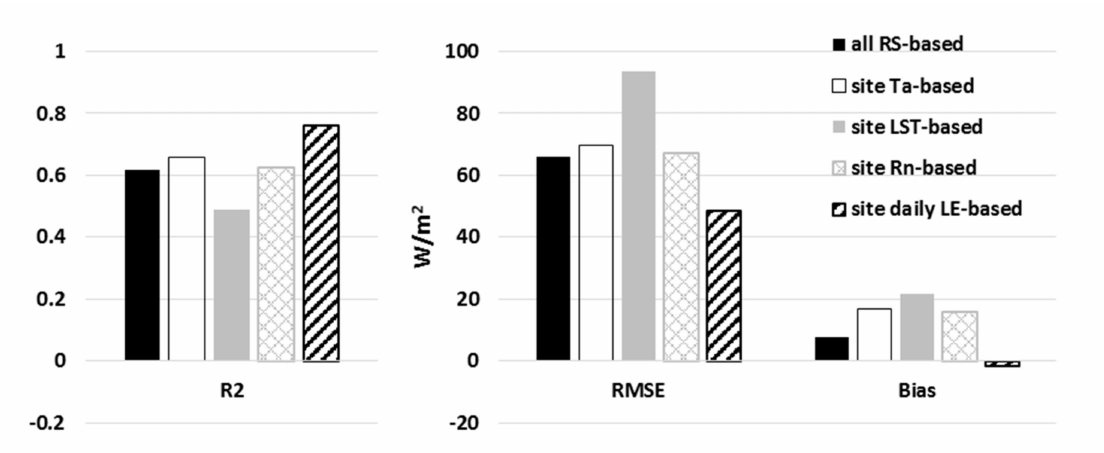
Figure 8. Evaluation results of instantaneous LE estimates based on each measured site